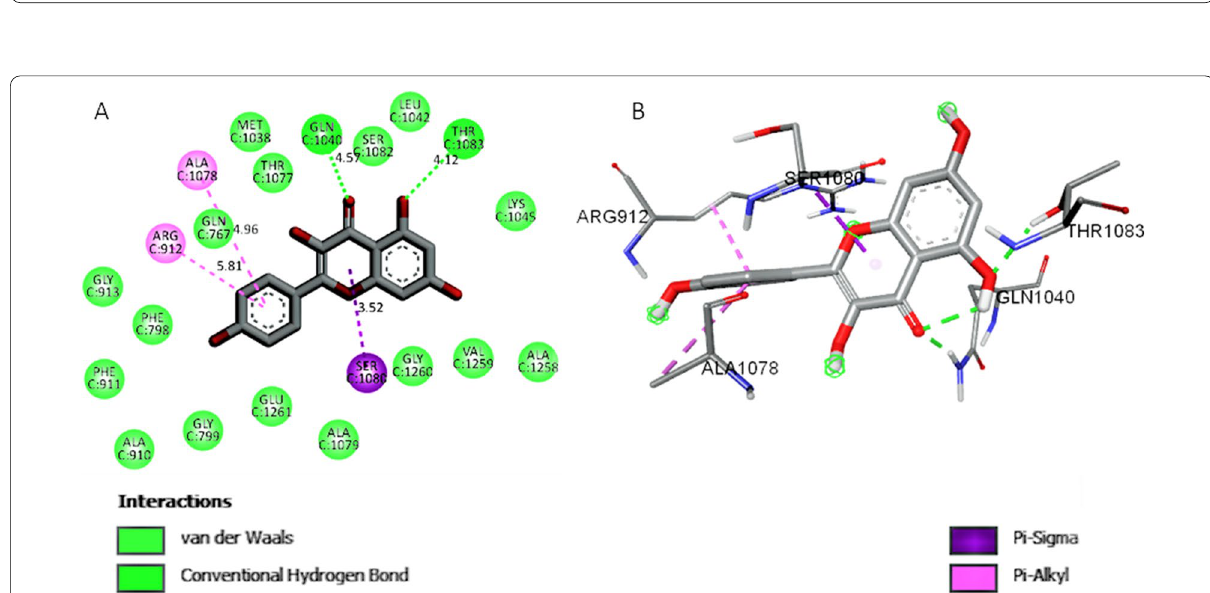
Fig. 9 2D ( A ) and 3D ( B ) simulations of kaempferol–XOD active site supramolecular bondings, showing a substrate-binding consequential pi-alky interaction with